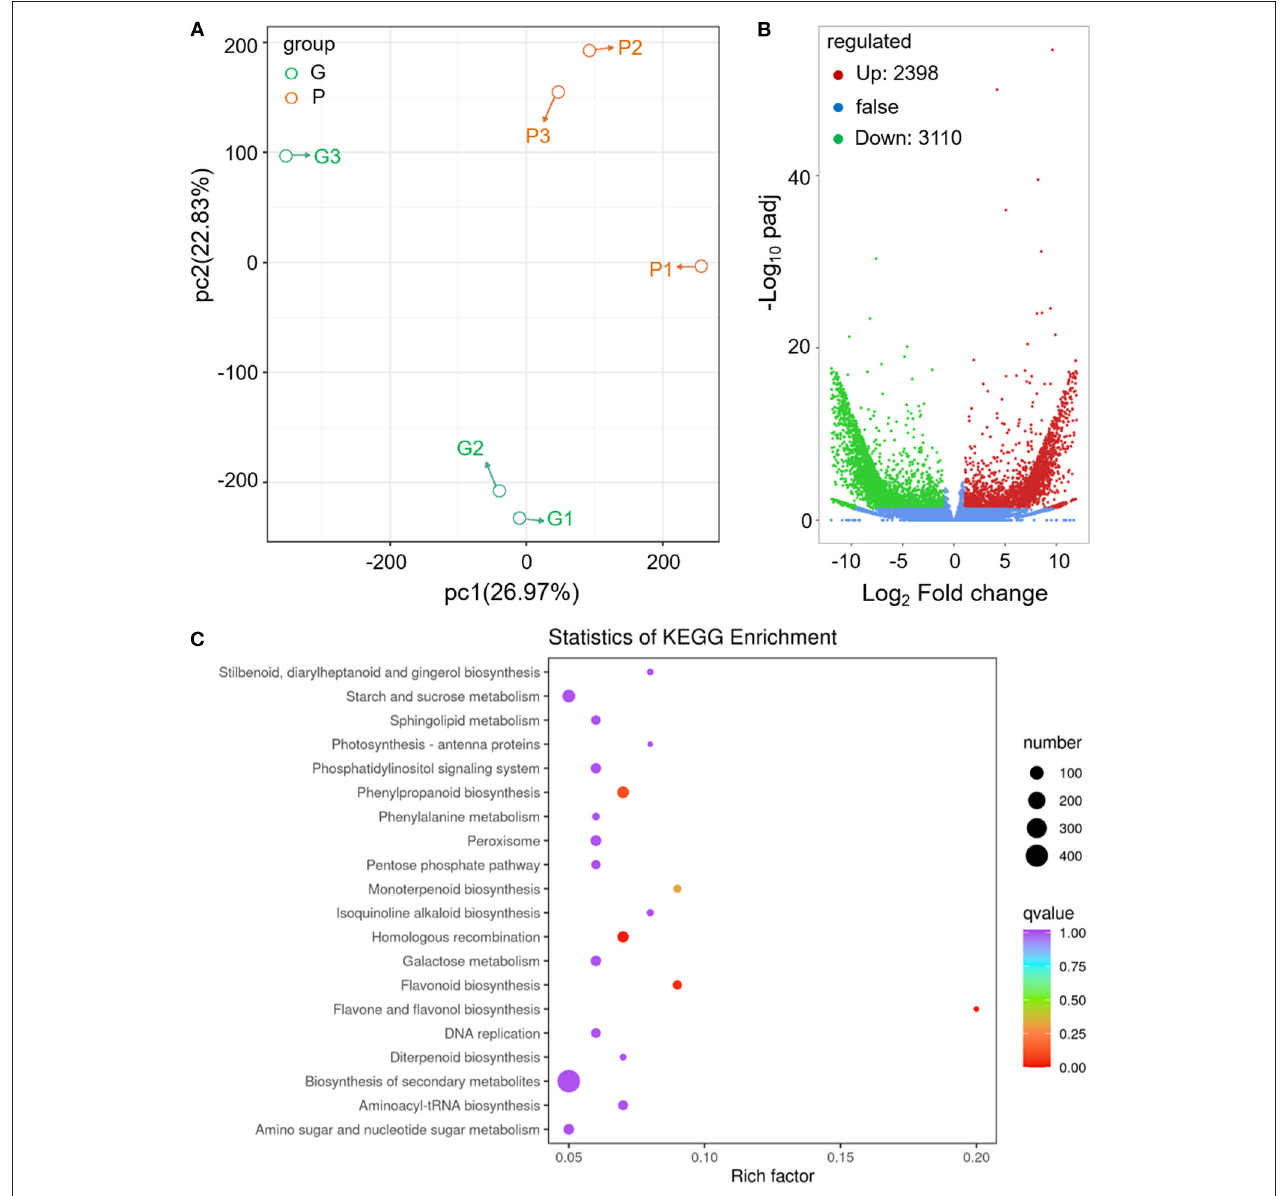
FIGURE 3 | Transcriptomics analysis of differential gene expression between different fennel varieties. (A) PCA of the different fennel samples. (B) DEGs between different fennel varieties indicated with volcano plots (G vs. P). The horizontal axis represents the value of log2-fold change. (C) Scatter plots of KEGG pathway